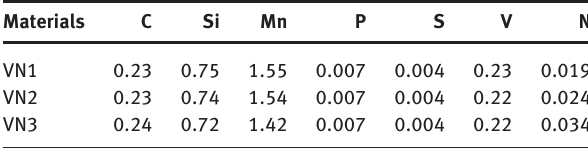
Table 1: Chemical composition of the experimental steels (mass%). Materials